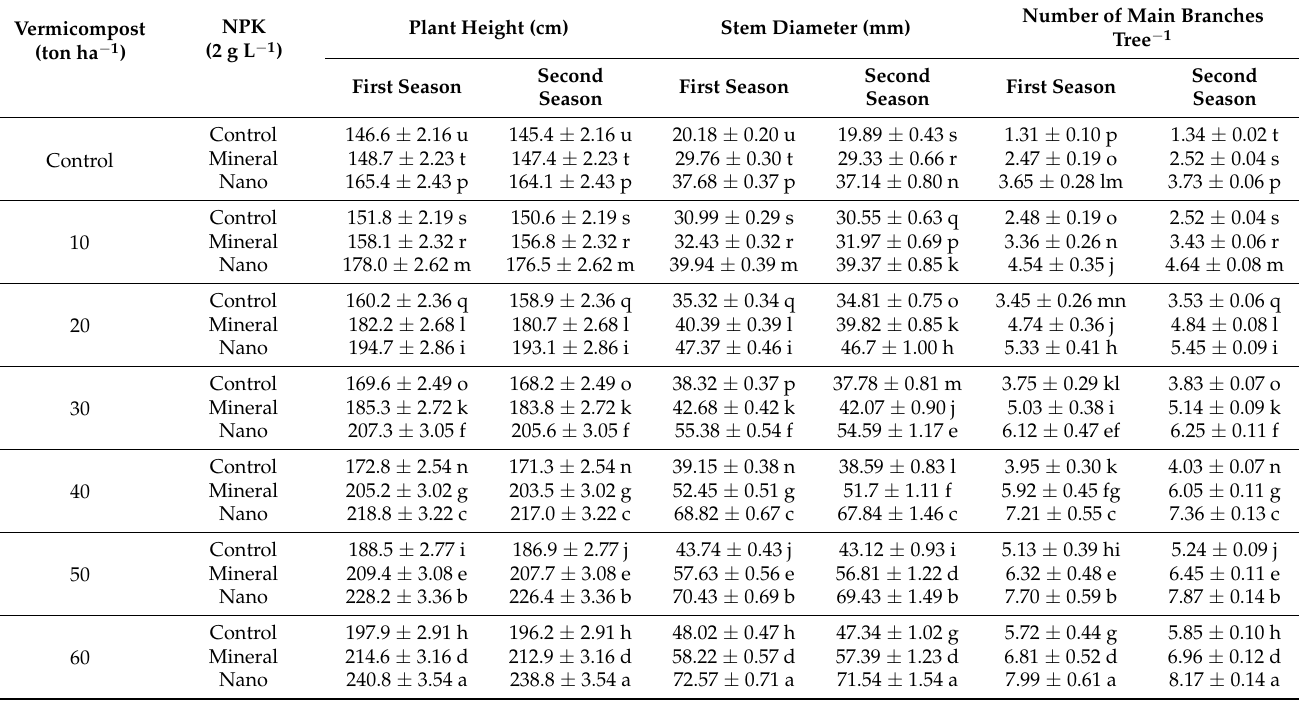
Table 1. The influence of combined treatments of vermicompost and NPK fertilization on the mean values of plant height (cm), stem diameter (mm), and number of main branches per tree of Moringa oleifera trees in the first and second seasons.